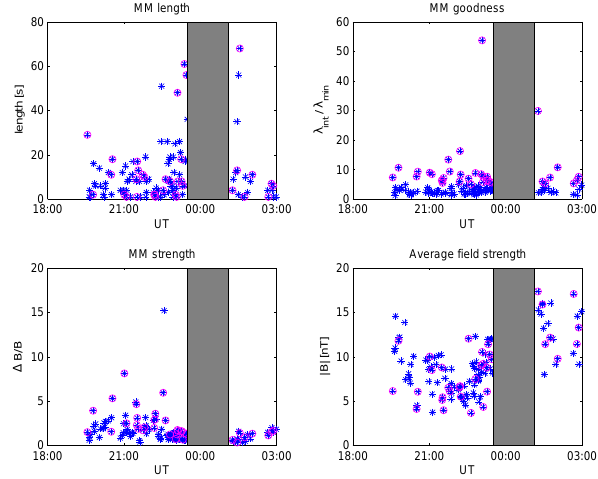
Figure 5. Overview of all the time intervals with MMs for the Fig.5. OverviewofallthetimeintervalswithMMsfortheGiottoflyby. Shownarethelengthoftheinterval, Giotto flyby. Shown are the length of the interval, the goodness of thegoodnessoftheMVA,thestrengthoftheMMsandtheaveragebackgroundfieldstrength. Theredcircles showforwhichMMstheMVAgoodnessisgreaterthan5. Thegray-shadedareaisthemagneticpile-upregion the MVA, the strength of the MMs and the average background field inwhichnoMMsareexpected. strength. The magenta circles show for which MMs the MVA good- ness is greater than 5. The gray-shaded area is the magnetic pile-up region in which no MMs are